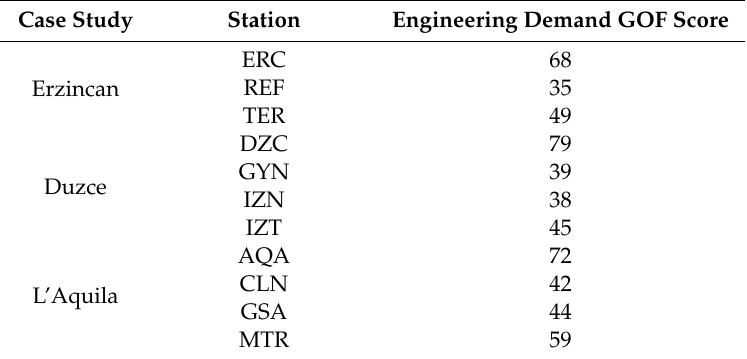
Table 7. Station-wise engineering demand GOF scores for all case